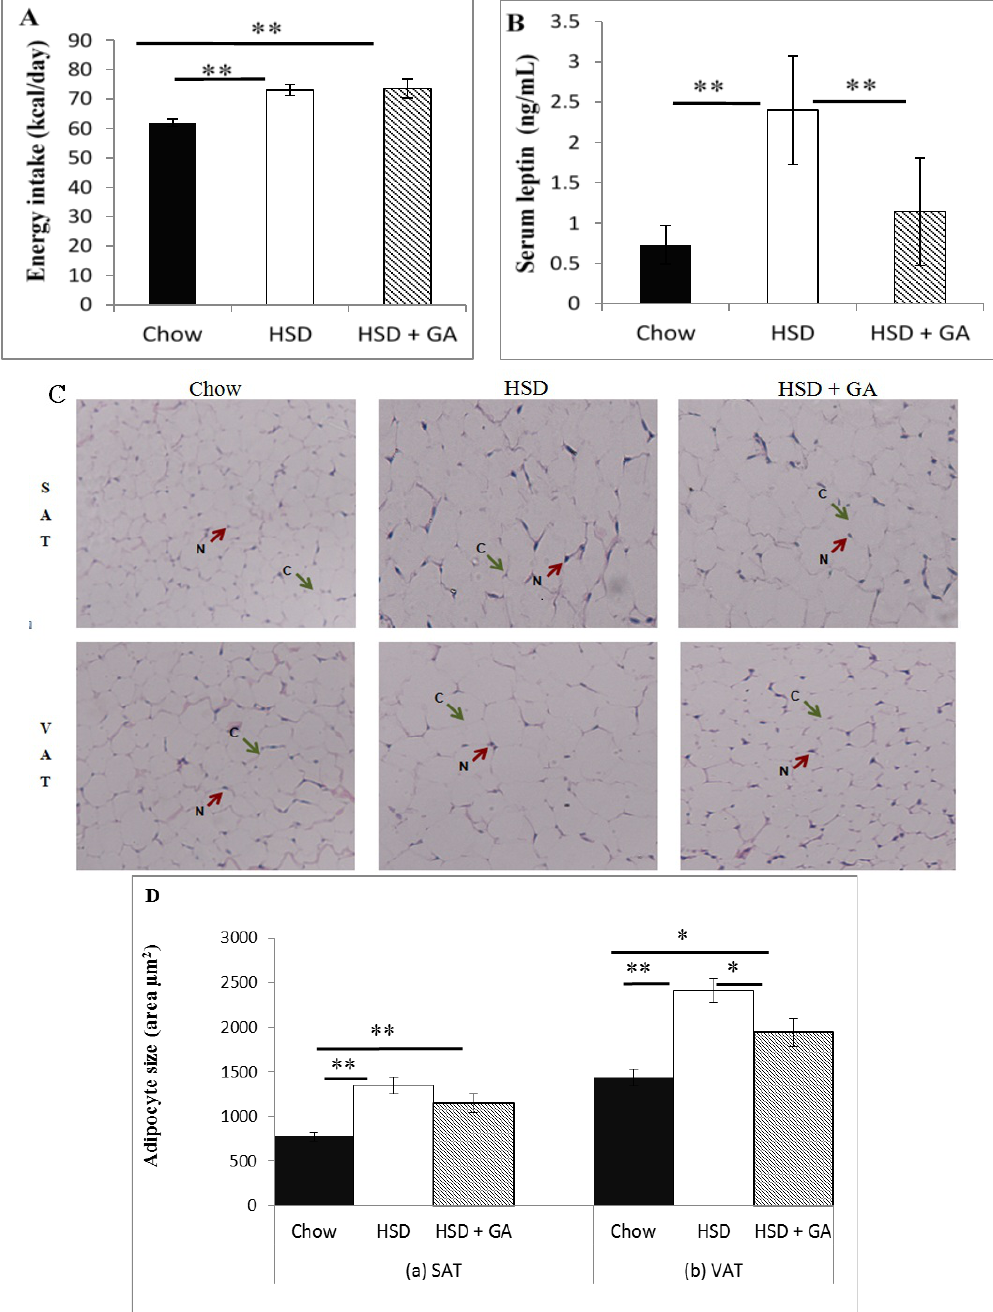
Figure 1. Glycyrrhizic acid consumption ameliorated effects of a high-sucrose diet on metabolic parameters. ( A ) Daily energy intake and ( B ) serum leptin concentrations, as well as ( C ) representative examples of haemotoxylin and eosin (H & E) stained sections of subcutaneous and visceral adipose tissue (SAT and VAT, 200× magnification) and ( D ) adipocyte size (cross-sectional area) in SAT and VAT depots from rats fed normal chow, a high-sucrose diet (HSD), or a HSD supplemented with 100 mg/kg per day glycyrrhizic acid (HSD + GA), administered orally for four weeks. One unit (U) of 11β-HSD2 activity is defined as one picomole of 11-dehydrocorticosterone produced per 50 mg of tissue protein used, per h of incubation at 37 °C. Data are means ± SEM of 8 male rats per group. * p ≤ 0.05, ** p ≤ 0.01 for the comparison shown by horizontal